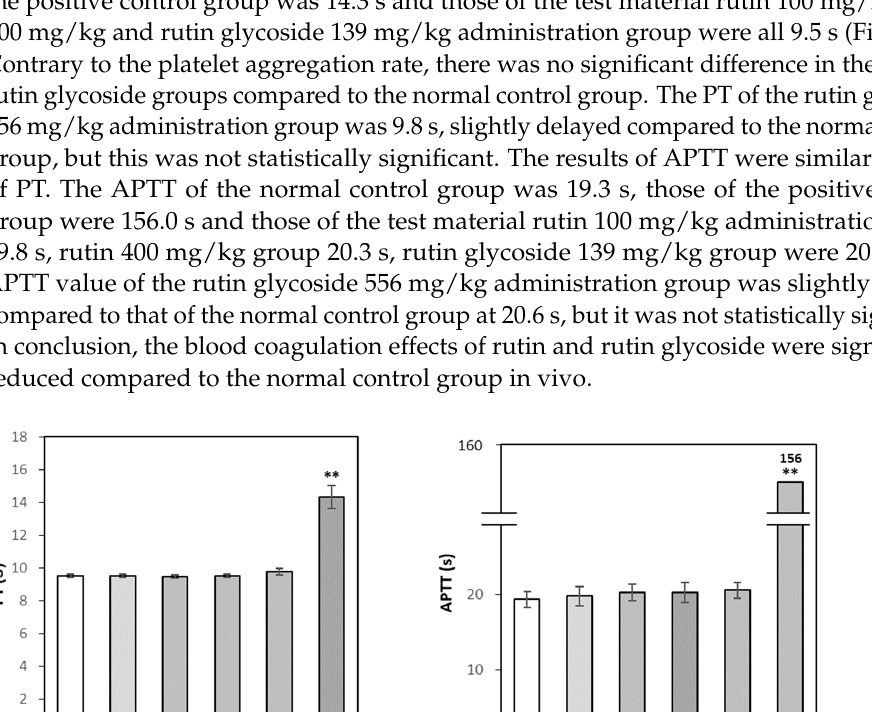
Figure 10. PT ( A ) and APTT ( B ) of PPP in vivo . Each time point represented the mean + S.E. n = 8 (G2, n = 4). CTR − means normal control, CTR+ means positive control (heparin), Ru G means rutin